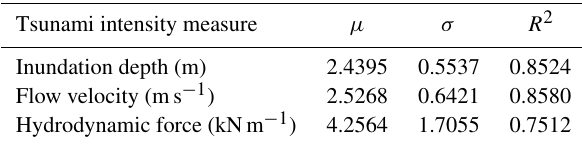
Table 1. Statistical parameters for developed fragility curves ob- tained from a normal